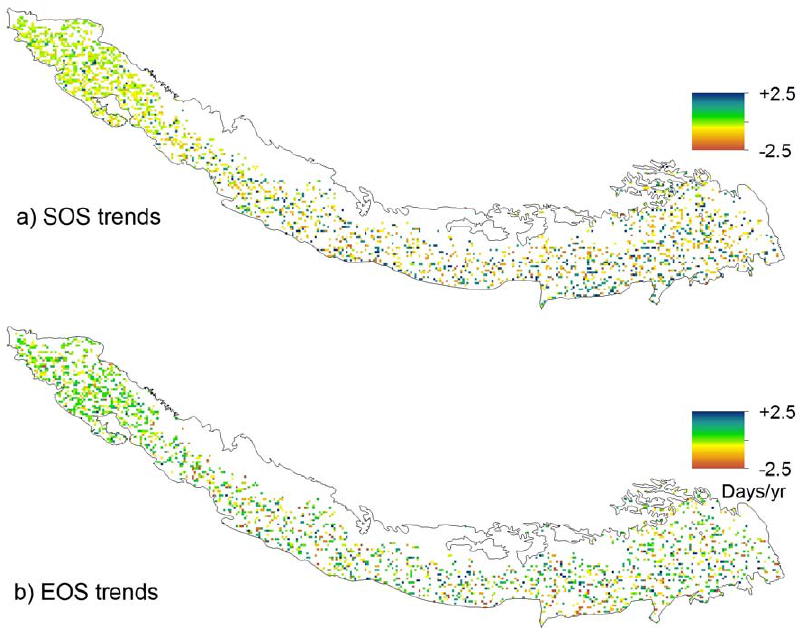
Figure 4. Spatial distribution of significant (P , 0.10) SOS and EOS trends in the Himalayas from 1982 – 2006.